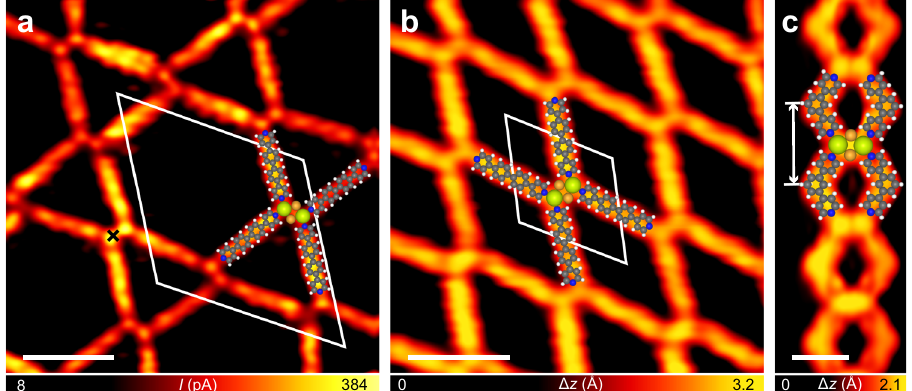
Fig. 4 Coordination structures involving Ce and 3 or 4 formed on Au(111). STM images of a the Kagome structure (in constant-height mode, V = 5 mV, I = 350 pA at the point marked by the cross, T = 77 K) and b the fi shing-net structure ( V = 100 mV, I = 20 pA, T = 77 K) formed by depositing 3 and Ce on Au(111), and c the chain-like structure ( V = − 1 mV, I = − 50 pA, T = 4.3 K) formed by depositing 4 and Ce on Au(111). The unit cells of the Kagome and the fi shing-net structures are highlighted by the white parallelograms in a and b . The 1D periodicity of the chain-like structure is marked by the white arrow in c . The structural motifs constructing the coordination structures are illustrated by the superimposed molecular models. Scale bars: a 2 nm, b 2 nm, and c 1